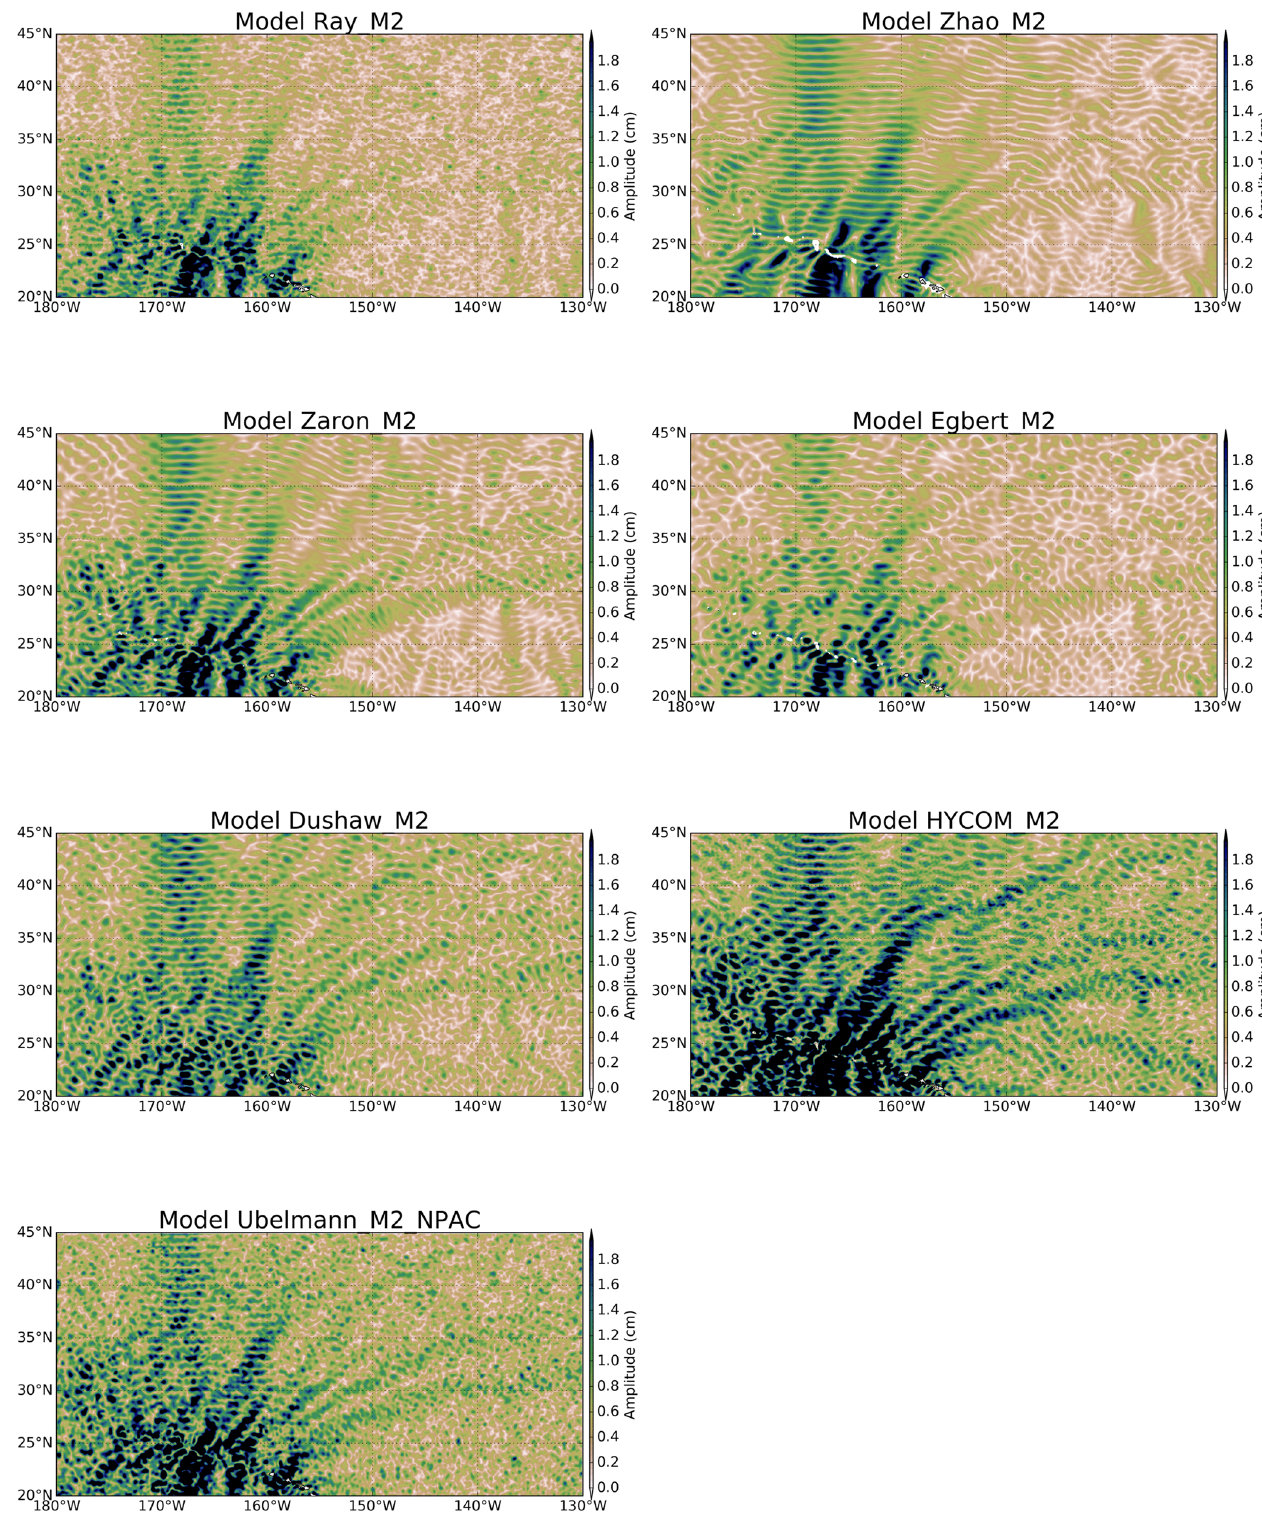
Figure 2. Amplitude of the IT models for the M 2 tide component in the NPAC region (north